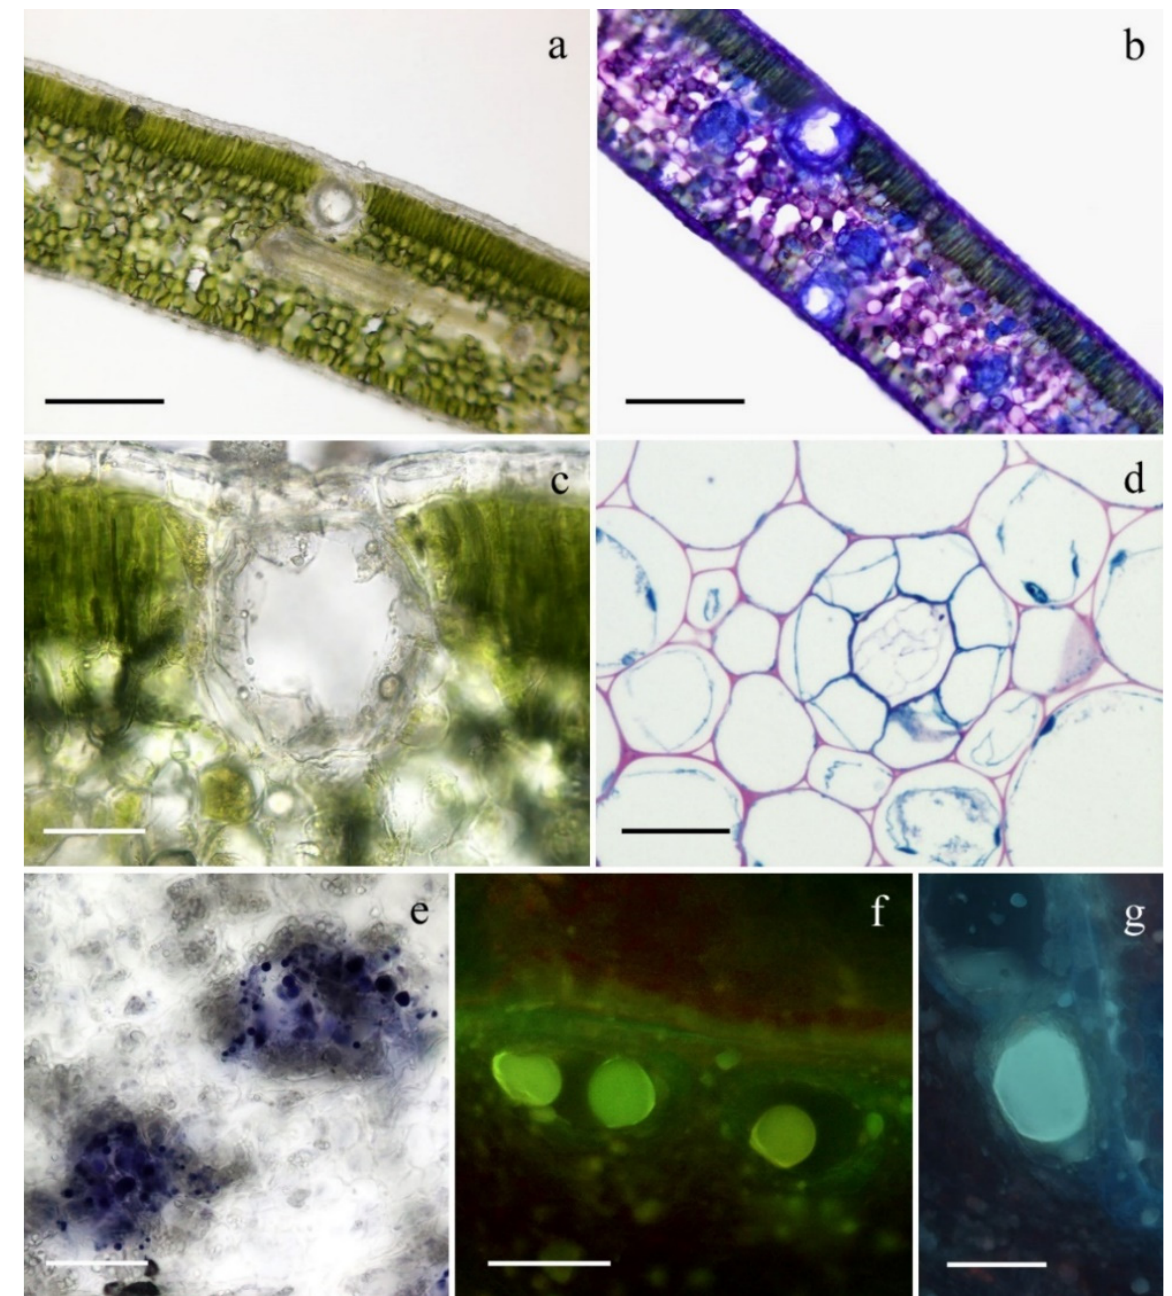
Figure 2. ( a , b ) Cross section of Myrtus communis subsp. communis leaf colorless ( a ) and stained with Toluidine blue dye, ( b ); ( c ) Detail of a leaf secretory cavity, colorless; ( d ) Detail of a shoot secretory cavity; ( e – g ) Histochemistry of secretory cavities: Nadi reagent ( e ), Fluoral Yellow-088 ( f ), AlCl 3 ( g ). Scale bars = 100 µ m ( a , b ); 25 µ m ( c , d , g ); 50 µ m ( e , f ). The secretory cavities, regardless of the distribution pattern, were globose-spheroidal in shape and had a diameter ranging from 10 to 50 µ m (Figure 2c). The cavities displayed a 1- layered epithelium consisting of secreting cells that released the secreted material inside the of colorless or pale-yellow material was observed; the secreted material consisted of small, densely packed droplets or of large clusters which filled the entire volume of the